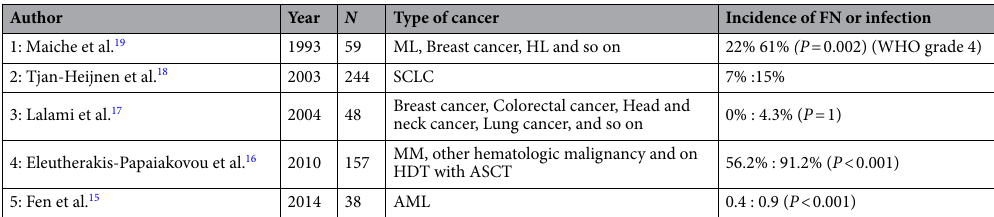
Table 4. Comparison of the prophylactic G-CSF plus antibiotics and prophylactic G-CSF alone for cancer in other regions. ML, malignant lymphoma; HL, Hodgkin’s lymphoma; SCLC, small cell lung cancer; MM, multiple myeloma; HDT, high-dose chemotherapy, ASCT, autologous stem-cell transplantation; AML, acute myelogenous